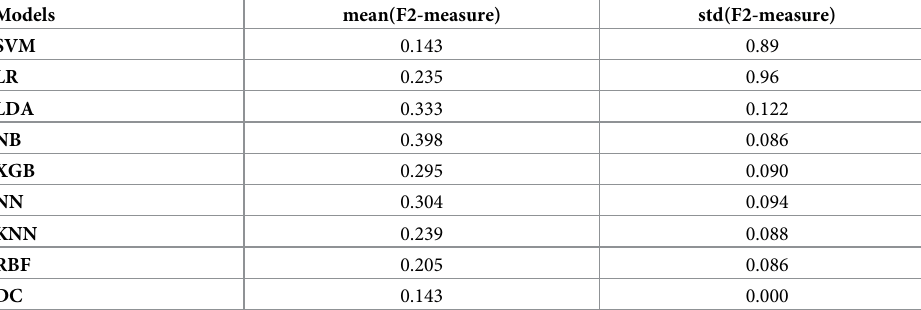
Table 3. F2-measure of machine learning